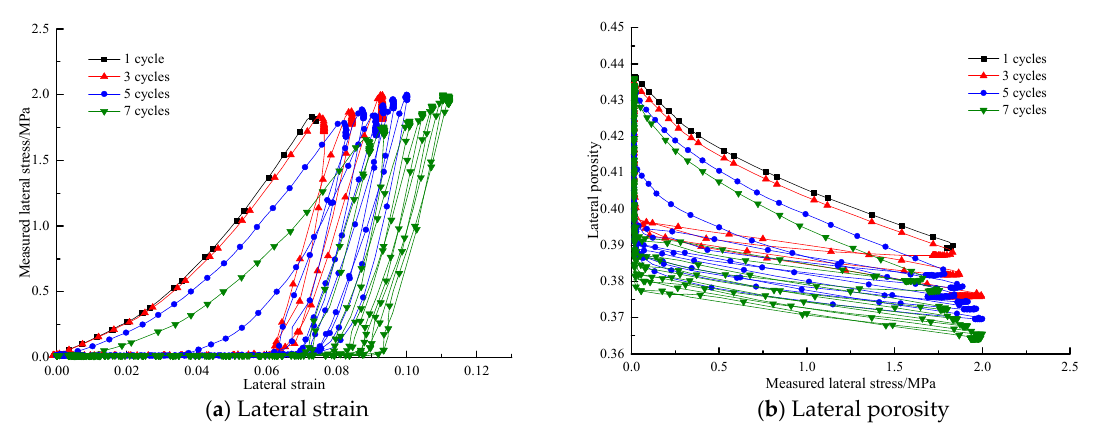
Figure 9. Changes in lateral strain and porosity during lateral loading.